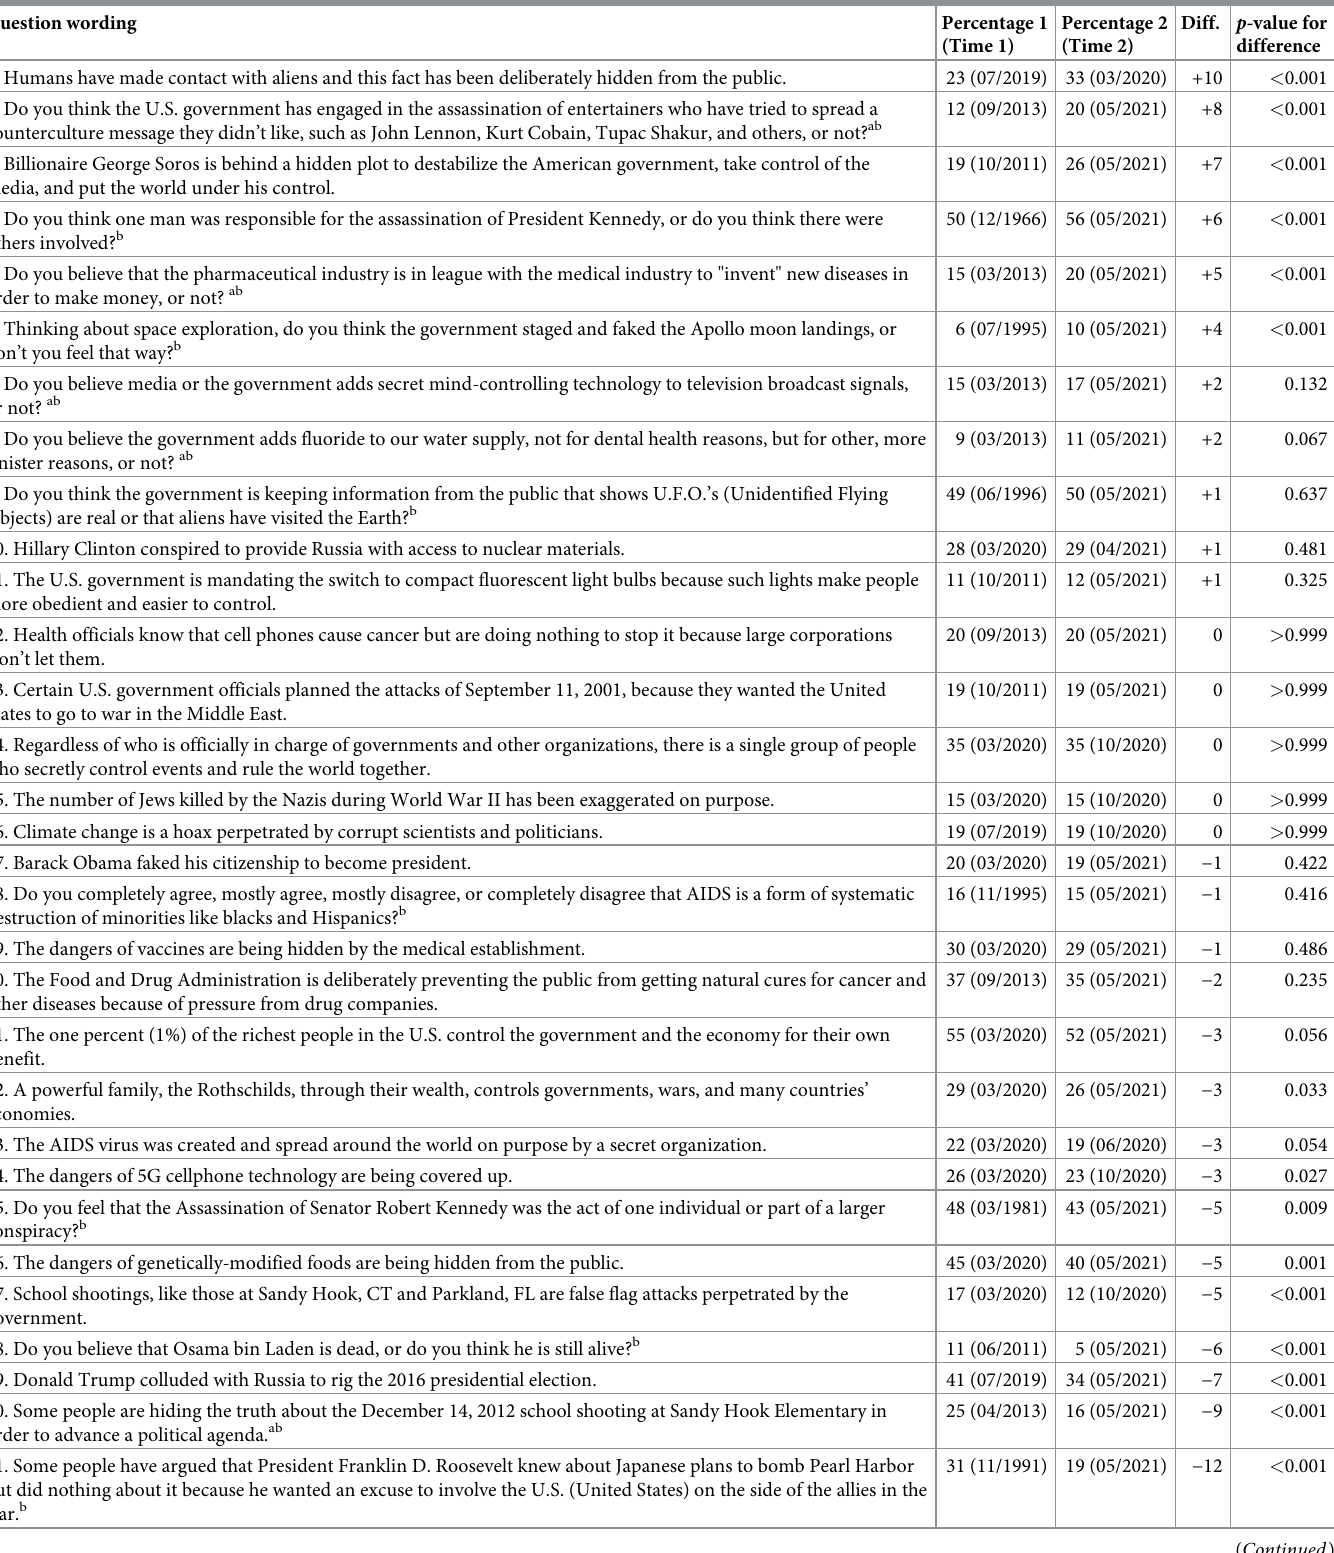
Table 3. Change in 37 additional conspiracy beliefs over